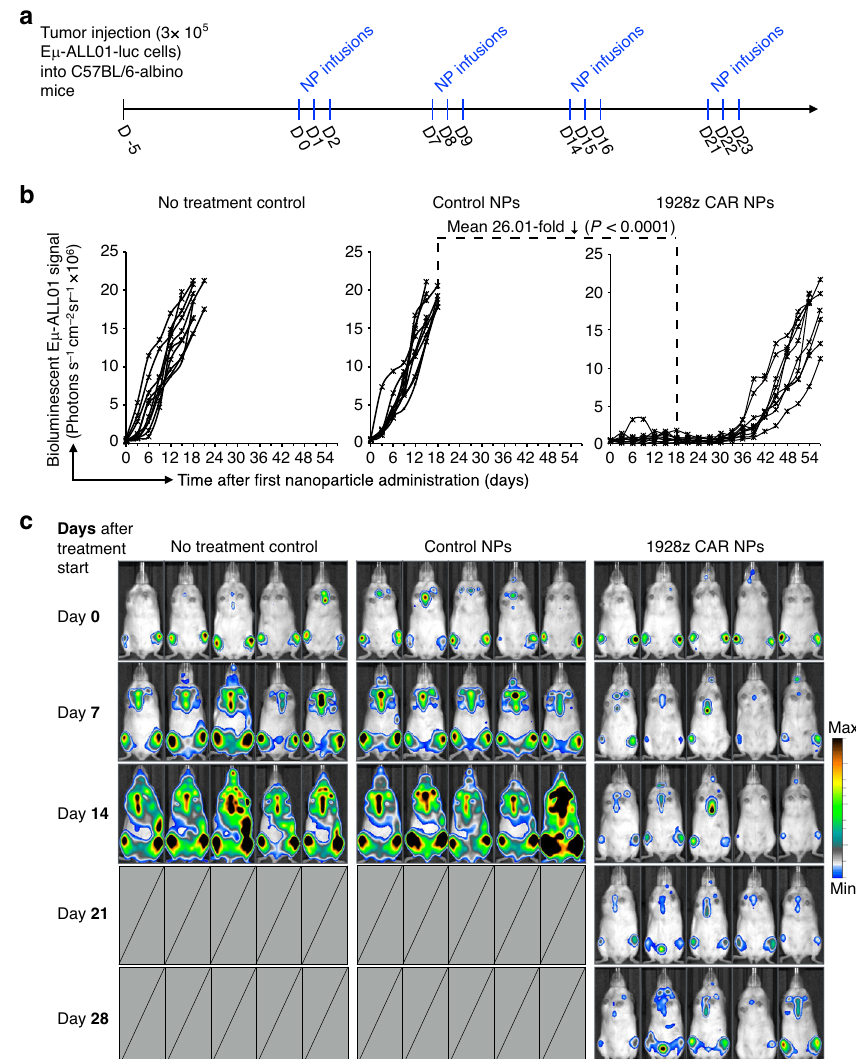
Fig. 6 Antileukemia response in immunocompetent mice. a Time line and dosing regimen. b Plots of E µ -ALL01 luciferase signal intensities after nanoparticle injections. Each line represents one animal and each dot re fl ects its whole animal photon count. Statistical differences were examined by two tailed unpaired Student ’ s t -test. Shown are data for ten mice per treatment condition pooled from two independent experiments. c Sequential bioimaging of fi re fl y luciferase-expressing E μ -ALL01 leukemia cells systemically injected into albino C57BL/6 mice. Five representative mice from each cohort ( n = 10)